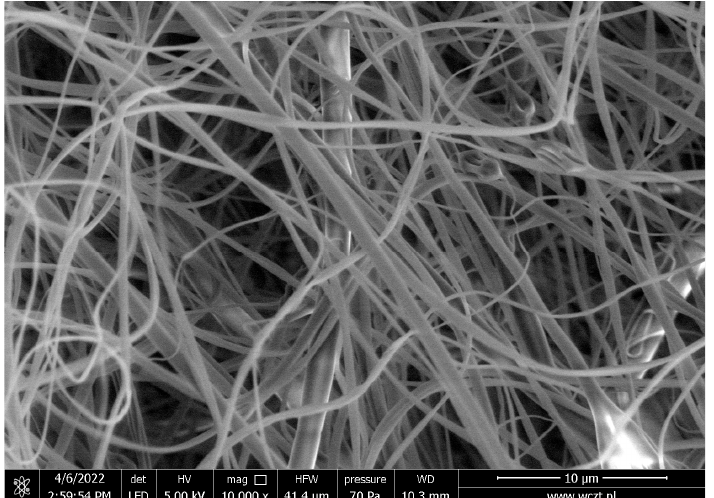
Figure 3. SEM image for nanofibers no. 5. The X-ray diffractograms showed that starting materials (lyophilized extract, PVP, HP β CD) display a high broadening of the diffraction peaks, and this with a low intensity indicates the amorphous structure of these systems (Figure 4) [13]. Moreover, background nanofibers produced from PVP and HP β CD, as well as final nanofibers no. 5, are also characterized by amorphousness.